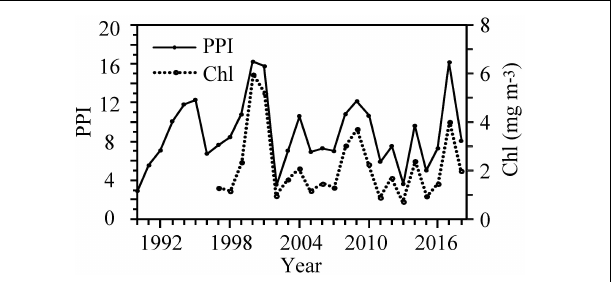
FIGURE 5 | Inter-annual variations in the PPI in the CS 1990–2018 and in the daily chl concentration (mean April–June) at station S